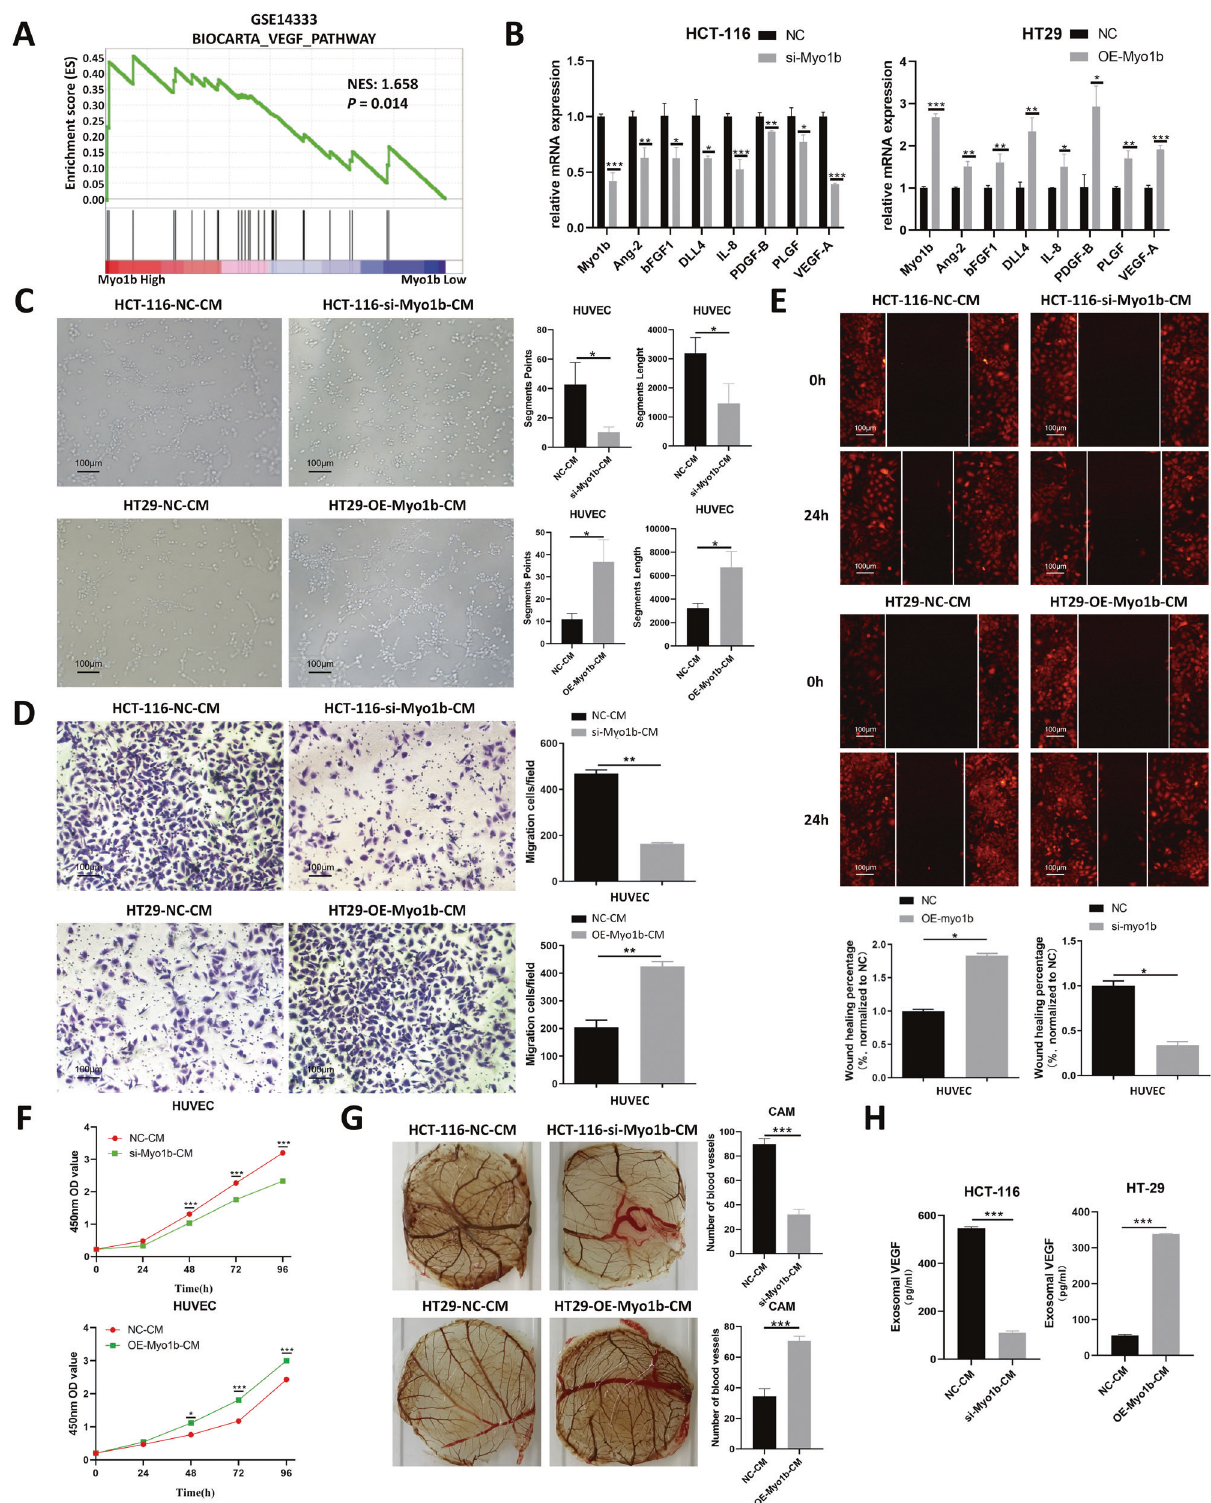
Fig. 2 Myo1b promotes CRC angiogenesis by enhancing VEGF secretion of CRC cells. A Gene set enrichment analysis (GSEA) indicated that VEGF pathway was positively enriched in patients harboring high Myo1b expression from GEO datasets (GSE14333). B RT-qPCR con fi rmed the ef fi ciency of si-Myo1b as well as OE-Myo1b in CRC cells and detected the effects of Myo1b on the expression of multiple angiogenesis-related factors in HCT-116 and HT29 cells. The conditioned medium (CM) of CRC cells (HCT-116 and HT29) with different Myo1b expression levels affected cell tube formation ( C ), migration ( D & E ) and proliferation ( F ) of HUVECs. G Blood vessels formed in representative images of the CAM assay after CM treatment. H The concentration of VEGF in the conditioned medium (CM) of HCT-116 and HT29 cells with different Myo1b expression levels was detected by ELISA assays. Each bar represented the mean ± SD ( n ≥ 3). * p < 0.05, ** p < 0.01, *** p < 0.001.